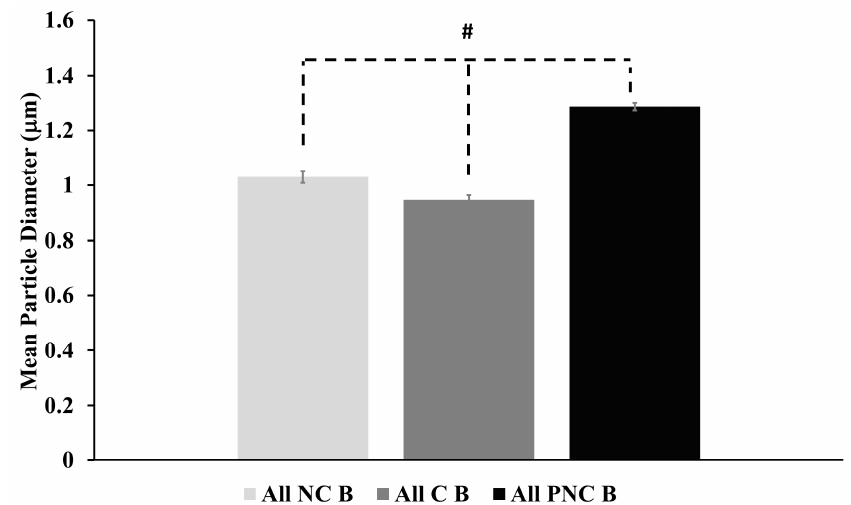
Figure 7. Mean diameters of tracked particles for each type of solution (C, NC, and PNC) are shown. The hashtag shape (#) denotes a statistically significant difference according to Student’s two-tailed t -tests at alpha = 0.01. Error bars represent one standard deviation from the cell-to-cell mean value.